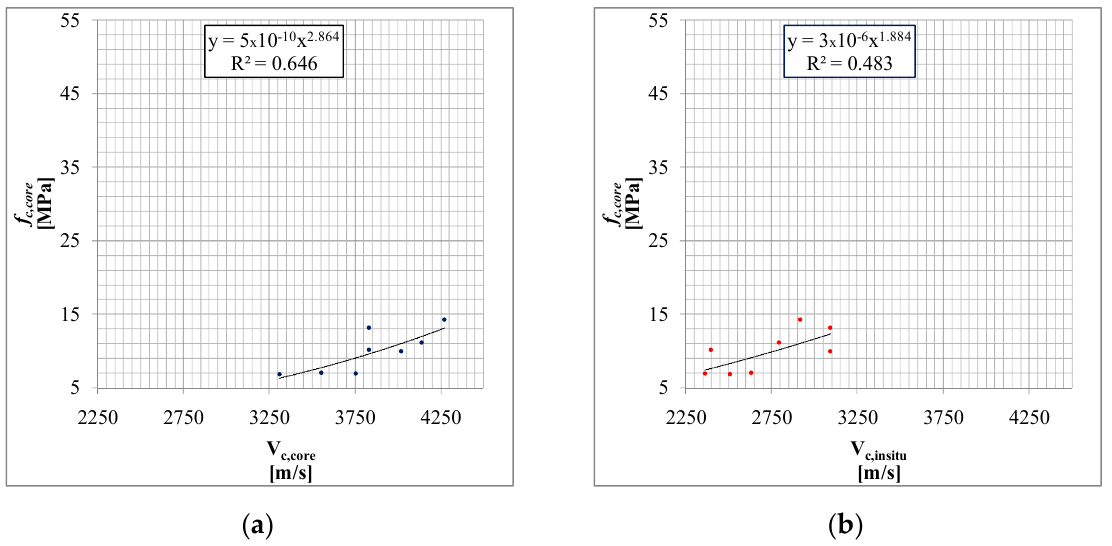
Figure 13. Ultrasonic velocity samples vs. compressive concrete strength ( a ) and in situ ultrasonic velocity vs. compressive concrete strength ( b ). The comparisons are related to the various samples taken in situ at different constructions and sites.